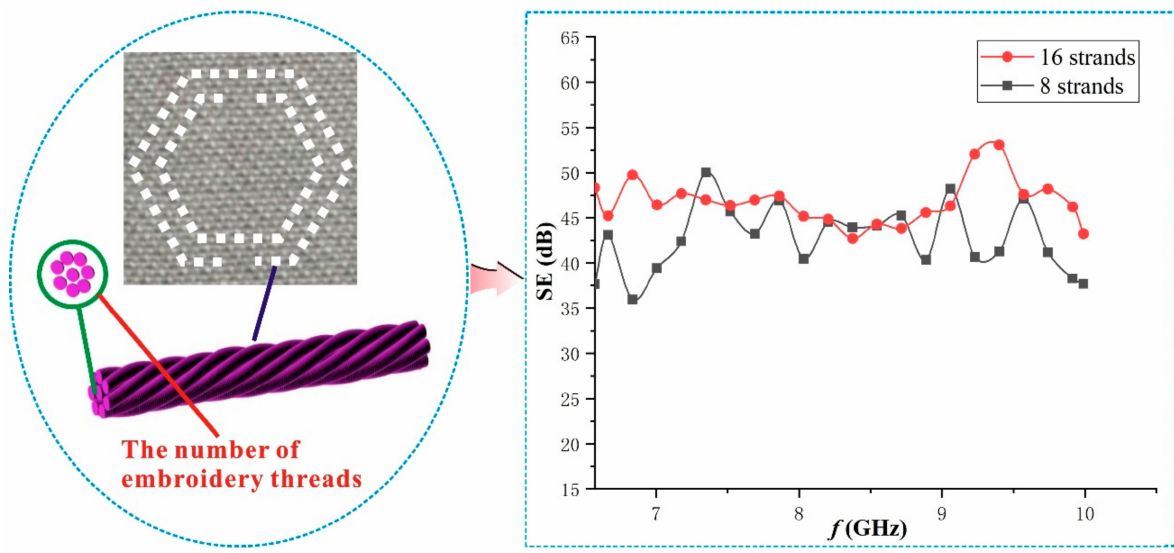
Figure 7. Influence of embroidery threads on the SE of the